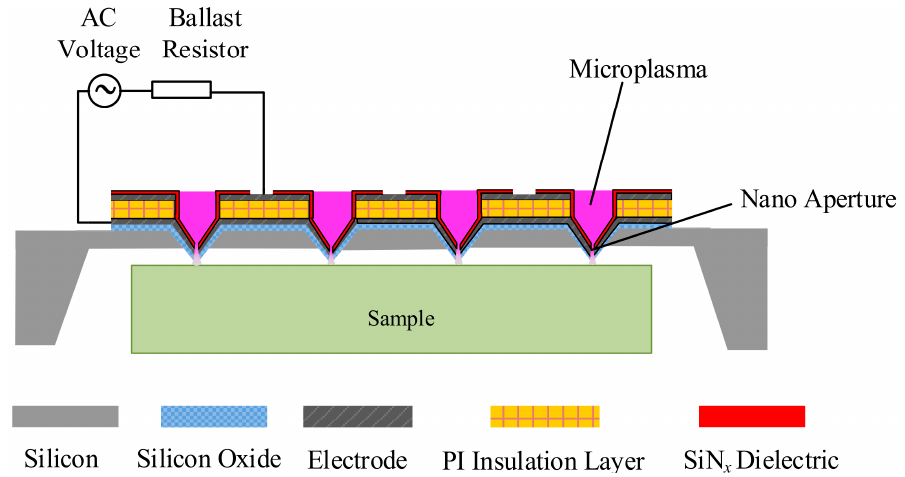
Figure 1. Schematic diagram of the inverted pyramid micro dielectric barrier discharge (MDBD) array for maskless nanoscale etching.